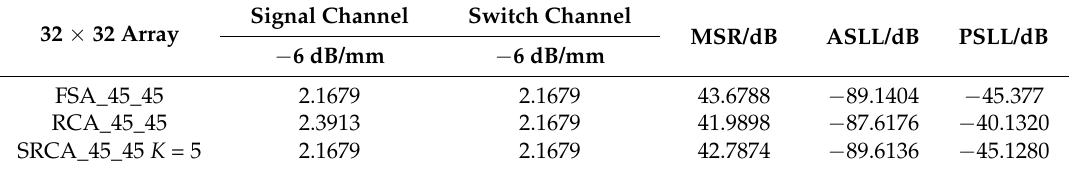
Table 4. The measured parameters of FSA, RCA and SRCA θ 0 = 45 ◦ , ϕ 0 = 45 ◦ for a 32 × 32 array.